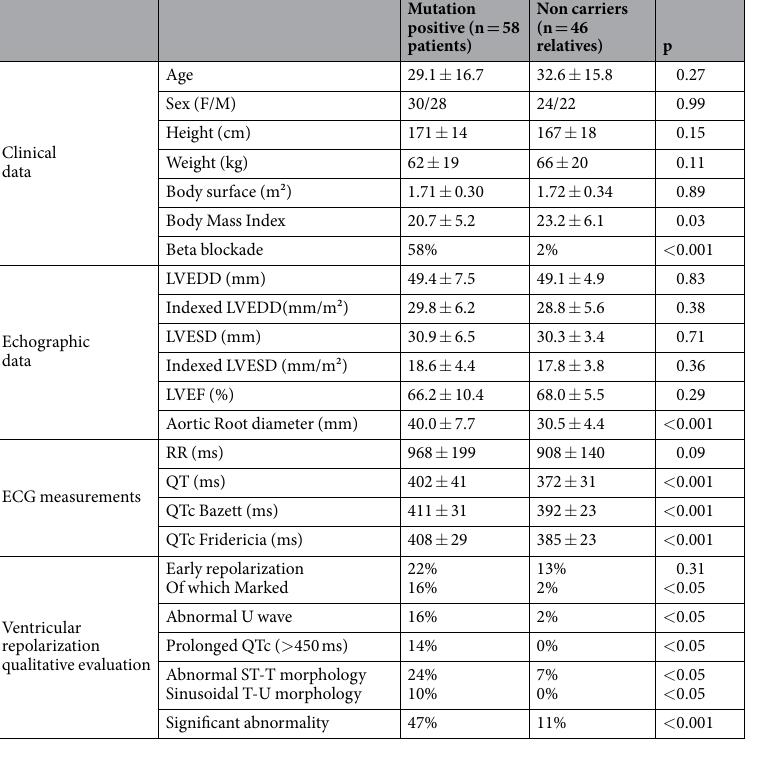
Table 1. Clinical, echographic and ECG data TGF β R2 group versus control